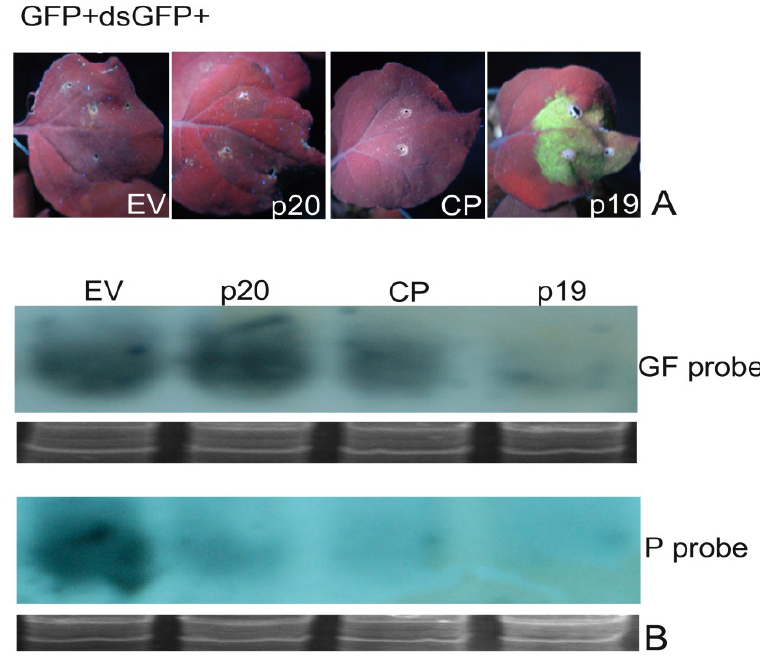
Figure 7. Effect of PMWaV-2 p20 and PMWaV-2 CP proteins on primary and secondary siRNA accumulation. ( A ) Leaves of WT N. benthamiana co-infiltrated with A. tumefaciens cultures harboring 35S-sGFP, 35S-dsGF, 35S-PMWaV-2 p20 or CP, 35S-EV, or 35S-p19. The 35S-p19 and 35S-empty vector (EV) are positive and negative controls, respectively. Photographs were taken at 6 dpi. ( B ) Northern blot analysis of GFP siRNAs from total RNA extracted from the infiltrated leaf at 6 dpi with either GF or P specific probes as indicated in the figure. Equal loading of mRNAs and siRNAs were estimated by ethidium bromide staining of ribosomal